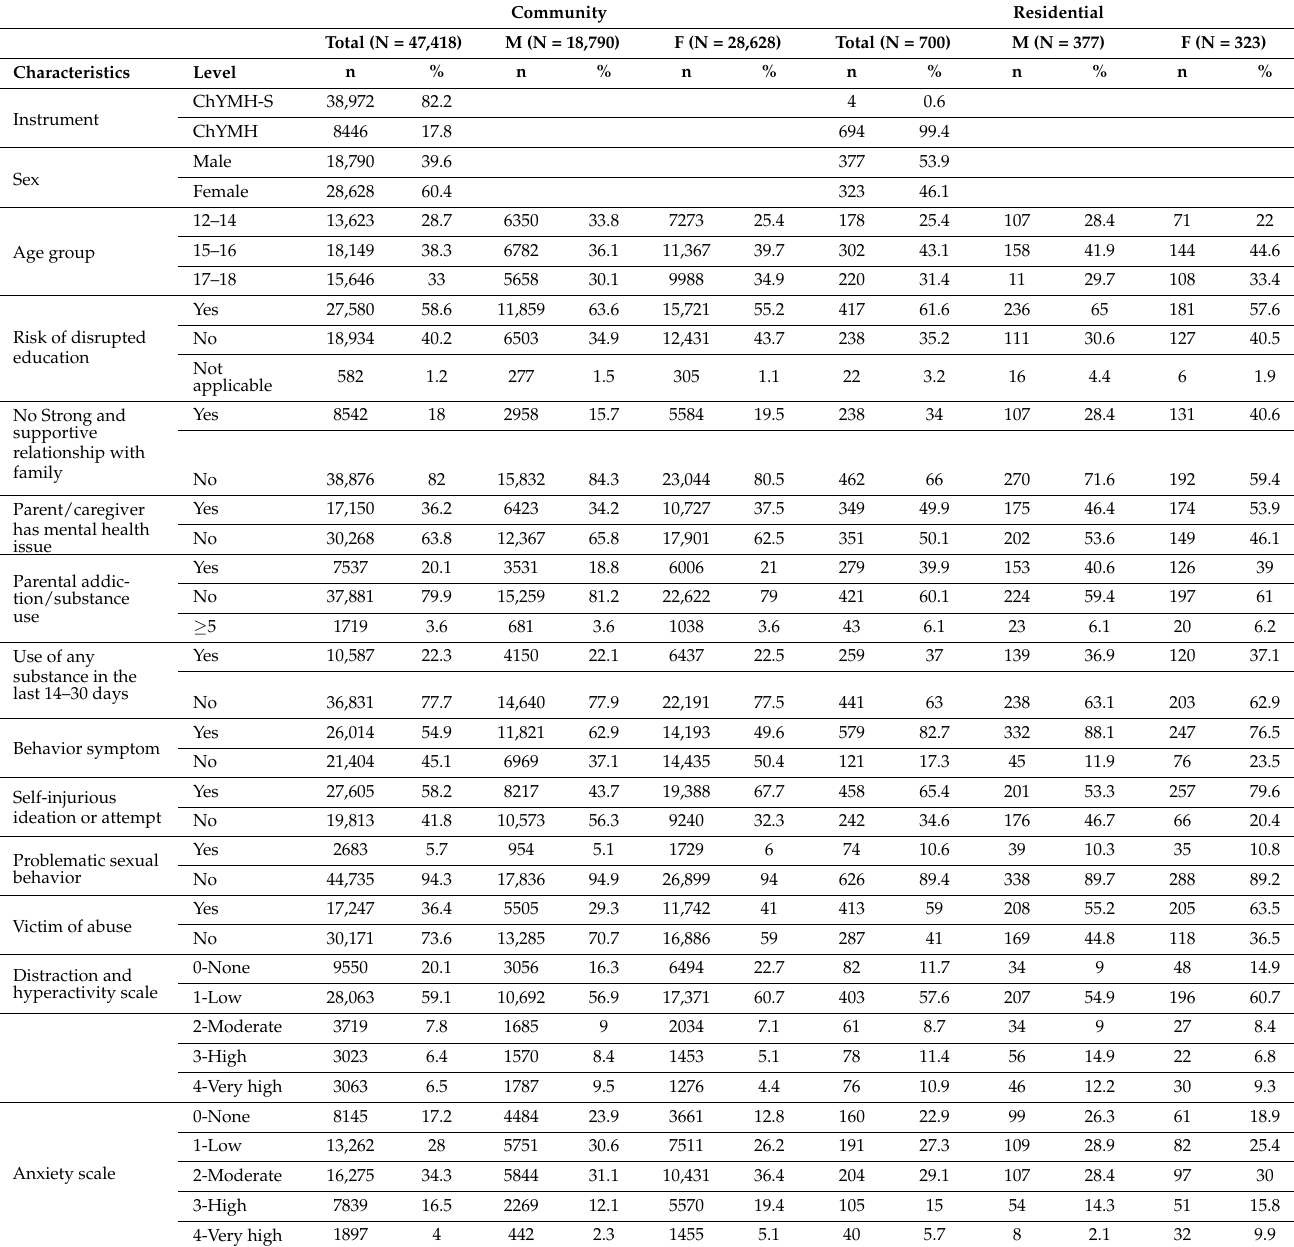
Table 2. Characteristics of the study